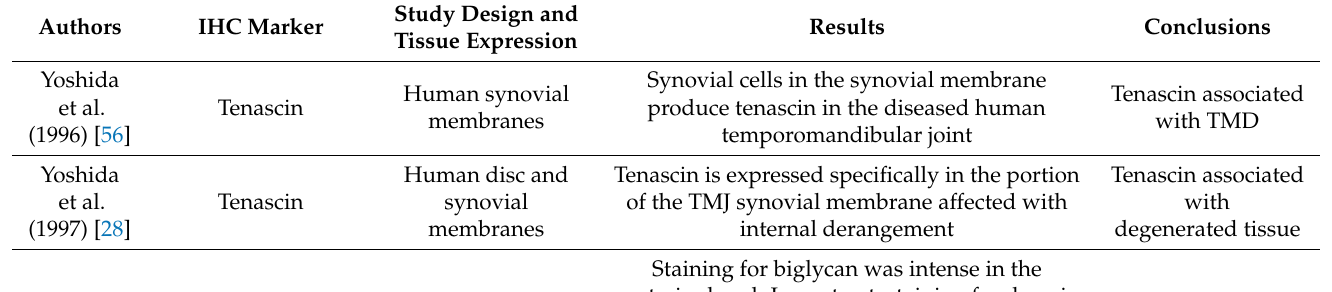
Table 3. Proteoglycans (Tenascin, vimentin, fibronectin, decorin, biglycan, versican,